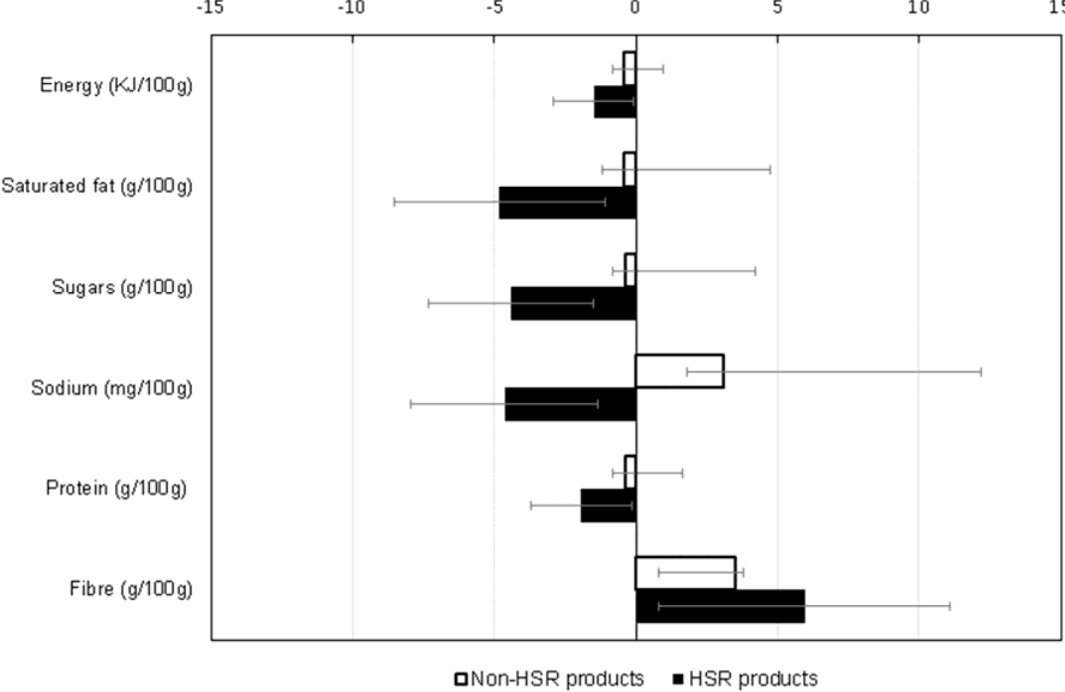
Figure 4. Percent changes in nutrient composition between 2014 and 2016 for Health Star Rating (HSR) and non-HSR products (estimates weighted by household purchase volumes). Note: Error bars indicate the 95% confidence intervals. Percent change calculated by estimating % change for each product between two years, and then estimating overall mean of all % changes. Fibre values were missing (not reported on the Nutrition Information Panel) for 209 HSR-labeled products (50%) and 5796 non-HSR-labeled products (77%).